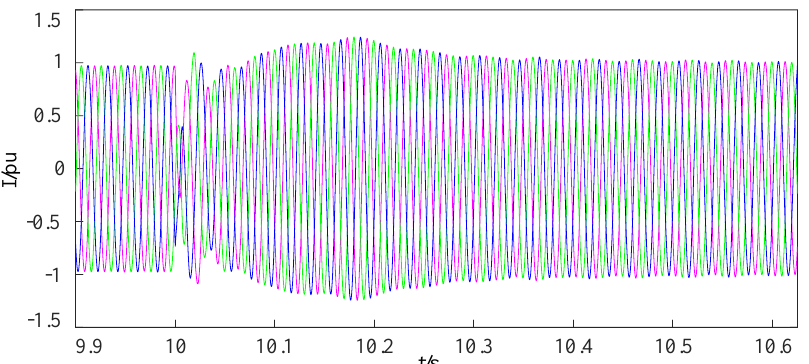
Figure 3. The fault currents of MMC (the red, blue, and green lines denote the currents of phase A, Phase B, and Phase C, respectively).